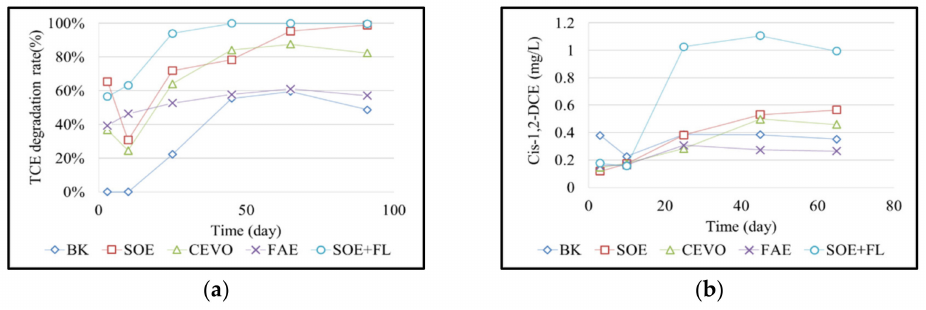
Figure 5. Effects of different emulsions on chlorinated pollutants in the microcosm tests: ( a ) TCE and ( b ) cis